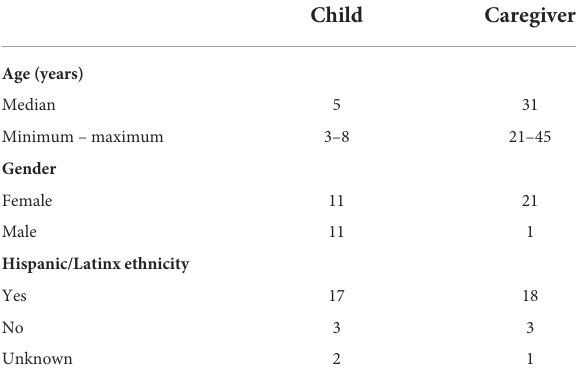
TABLE 1 Characteristics of the participants of the Thirsty for a Smile study.